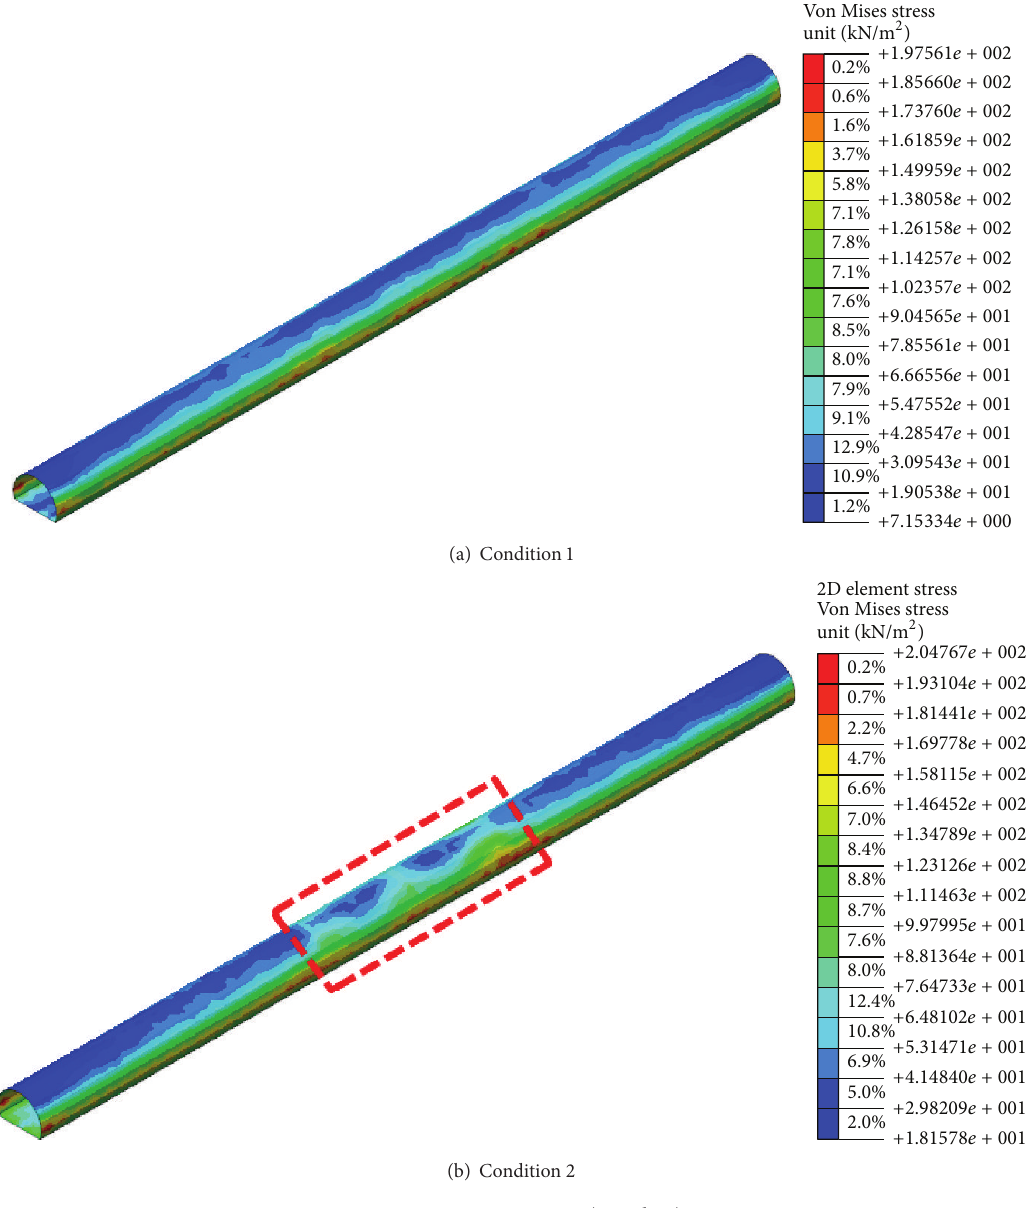
Figure 14: Von Mises stress (unit: